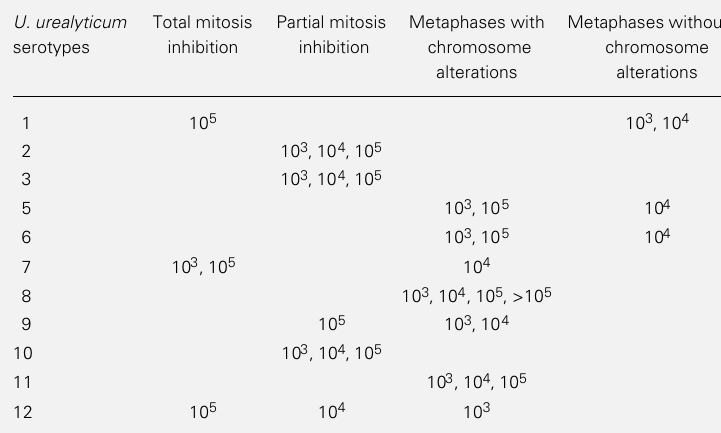
Table 1 - Effect of serotype and concentration on U. urealyticum -induced modifications of human lymphocyte mitosis in vitro . Concentration is reported as CCU/ml (color changing